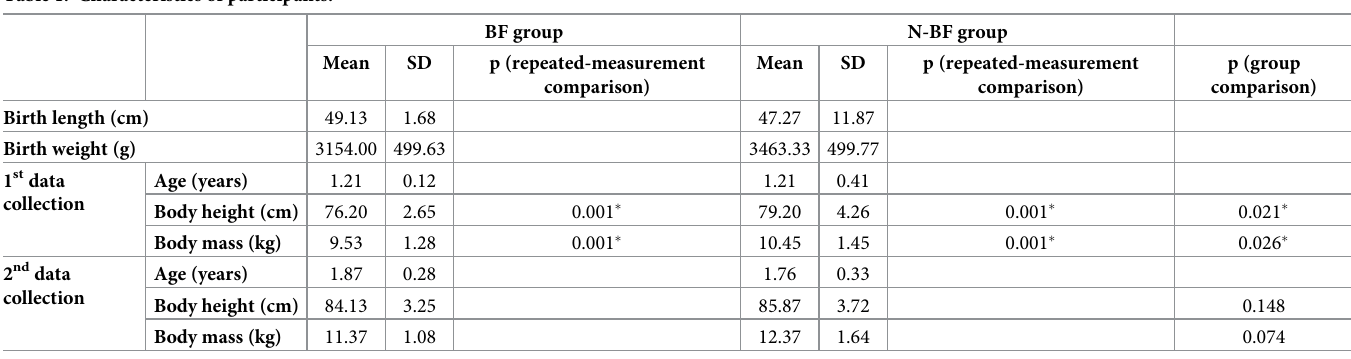
Table 1. Characteristics of participants.